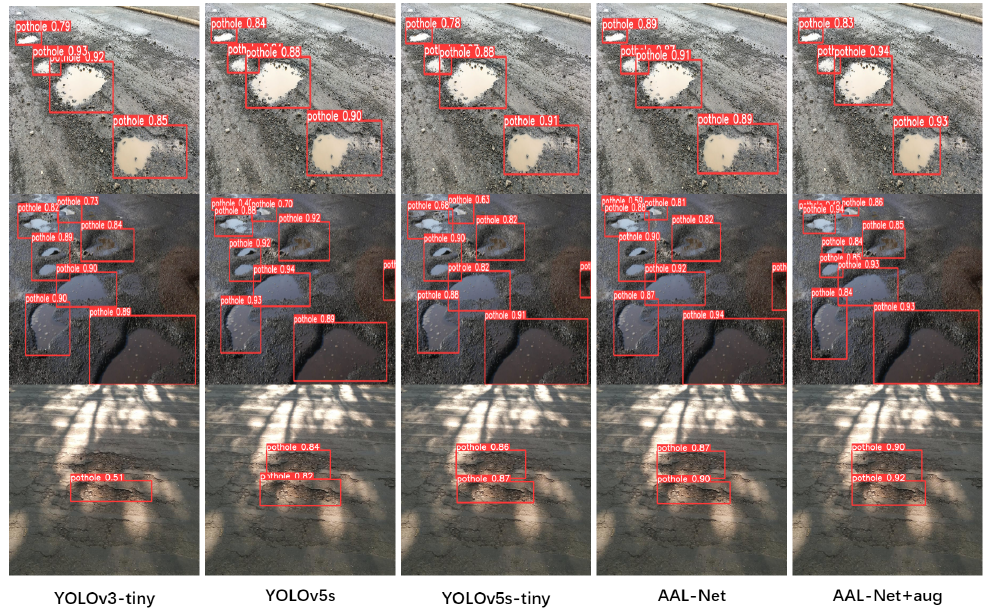
Figure 11. Visualization of image detection on the self-made dataset using different methods. Similarly, as shown in Table 4, in the pothole600 dataset, the F1 values of AAL-Net are 6.06%, 1.53%, and 0.42% higher than those of the YOLOv3-tiny, YOLOv5s, and YOLOv5s- tiny models, respectively. With our data augmentation method, the F1 value of the AAL-Net is increased by 0.4%. The experimental results (Figure 12) and the actual effects (Figure 13) are